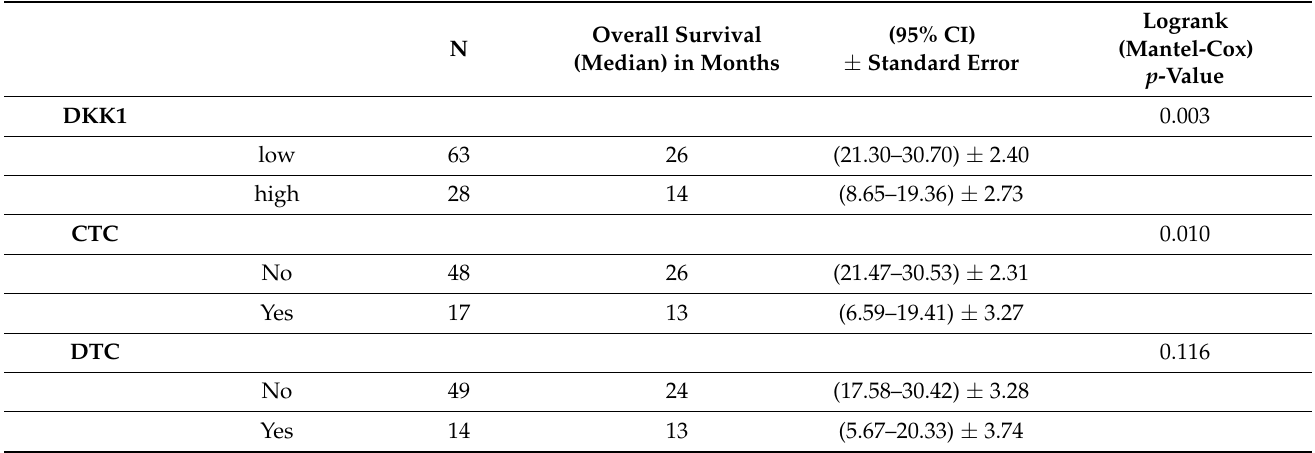
Figure 4. Kaplan–Meier survival curves displaying overall survival of 91 esophageal cancer patients. Kaplan–Meier survival curves displaying overall survival in months of esophageal cancer patients ( n = 91). Univariate analysis was carried out by logrank test (Mantel–Cox). A p -value < 0.05 was considered as statistically significant. Patients who were lost during follow up were censored at their last documented visit. ( A ) Overall survival of esophageal cancer patients with respect to S-DKK1 levels. Subgroups were built based on the mean values of all S-DKK1 levels in the 91 esophageal cancer patients. ( B ) Overall survival of esophageal cancer patients with respect to the presence of CTCs in the blood. A cut off value of at least one CTC was used to define the presence of CTCs. ( C ) Overall survival of esophageal cancer patients with respect to the presence of DTCs in the blood. A cut off value of at least one DTC was used to define the presence of DTCs. Table 5. Univariate analysis of overall survival in esophageal cancer patients with respect to S-DKK1, presence of CTCs and DTC